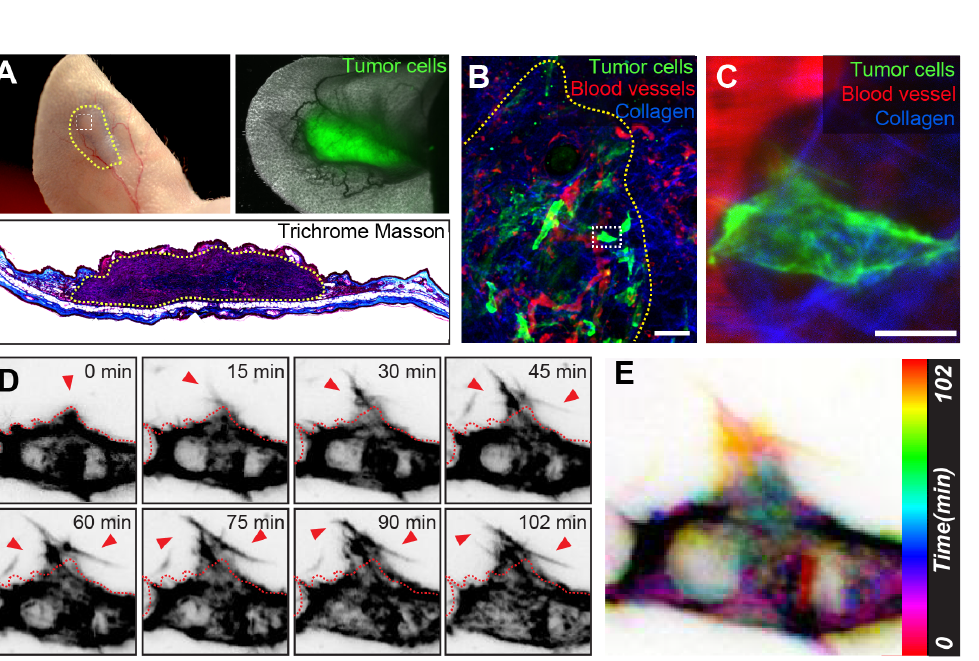
Figure 3. Full Volume Correlation of the ROI. A. 3D view of a 2PEM z-stack of mouse ear tissue, 7 days post-injection with GFP-expressing tumor cells (green). Vessels are stained with Evans Blue (red). Scale bar: 100 m m. See Movie S3. B. 3D model of the area that is indicated with a box in A. The cells of interest are segmented in green and numbered (1–6). The vessels are shown in red. The vessel bifurcation close to the skin surface is made transparent to reveal the cells underneath. Scale bar: 50 m m. C. X-Z slices through the 3D 2PEM volume, at the height of the cells of interest (circled). The numbers on the left bottom correspond to the numbers used in panel B to label the cells of interest. These views show the relative position of the cells with respect to the blood vessels (red) and the collagen-rich dermis (blue). D. Cartoon of the sectioning procedure. To approach the ROI and monitor the progression, serial thick sections were produced from the sample (the arrow indicates the sectioning direction) and imaged with LM (‘Approach + Correlation’). Approximating the location of the cells of interest, 240 nm sections for electron tomography were obtained (‘EM imaging ROI’). E. 500 nm toluidine-blue-stained sections that were obtained at different depths within the sample (the relative z-distance from the first section is indicated in top right corner of each panel). The vessels are segmented in red, hair follicles in brown. Scale bar: 100 m m. See Movie S3. F. 3D model of the hair follicles (brown), vessels (red) and NIRB markings (purple) segmented in the serial thick sections. Scale bar: 50 m m. See Movie S3. G. Overlay of a 3D model of the 2PEM z-stack (based on A, magenta) and a model of the vessels segmented in the serial thick sections (based on F, yellow). Overlapping areas are highlighted in white. Asterisks indicate vessel-forks that are visible in both datasets. Scale bar: 50 m m. See Movie S3. H. Correlation between 2PEM, LM and EM enabled retrieving the cells of interest (numbering in bottom right corner, as in B and C) in the sequence of serial thin sections. The electron transparent areas in proximity of the cells indicate a local absence of extracellular matrix components. The cause of this missing material remains to be elucidated. I. A selected area in the 2PEM dataset, showing a cell of interest (number 4 in B, C and H). J. Selection of the TEM images of cell 4, shown in panel I. The cell is modeled in green and the vessel lumen in red. For each image, we indicated the z-distance from the section where the cells was first spotted. Scale bar: 10 m m. K. Cell 4 (green) and the blood vessel lumen (red) are segmented in the serial sections (J). A 3D model of this segmentation reveals the shape of the cell, which closely resembles the 2PEM view of the same cell, shown in I. Scale bar: 10 m m. L-N: Electron tomography of a tumor cell (number 2 in B,C, and H), shown at low magnification in panel L. At the position of the box in L, a tomogram was obtained. Scale bar: 5 m m. See Movie S3. M. One selected virtual slice of the tomogram shows the complex architecture of the cell membrane and the fiber-like structure of extracellular matrix (ECM). N: The high image contrast of the ECM fibers enables semi-automatic segmentation of the fibers (shown in blue) within the 3D dataset. Scale bars in M and N: 500 nm. See Movie S3.